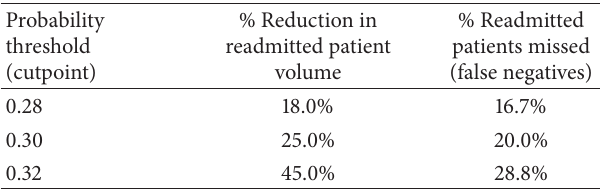
Table 2: Impact of using psychosocial factor-based readmission predictive model at varying probability cutpoints.